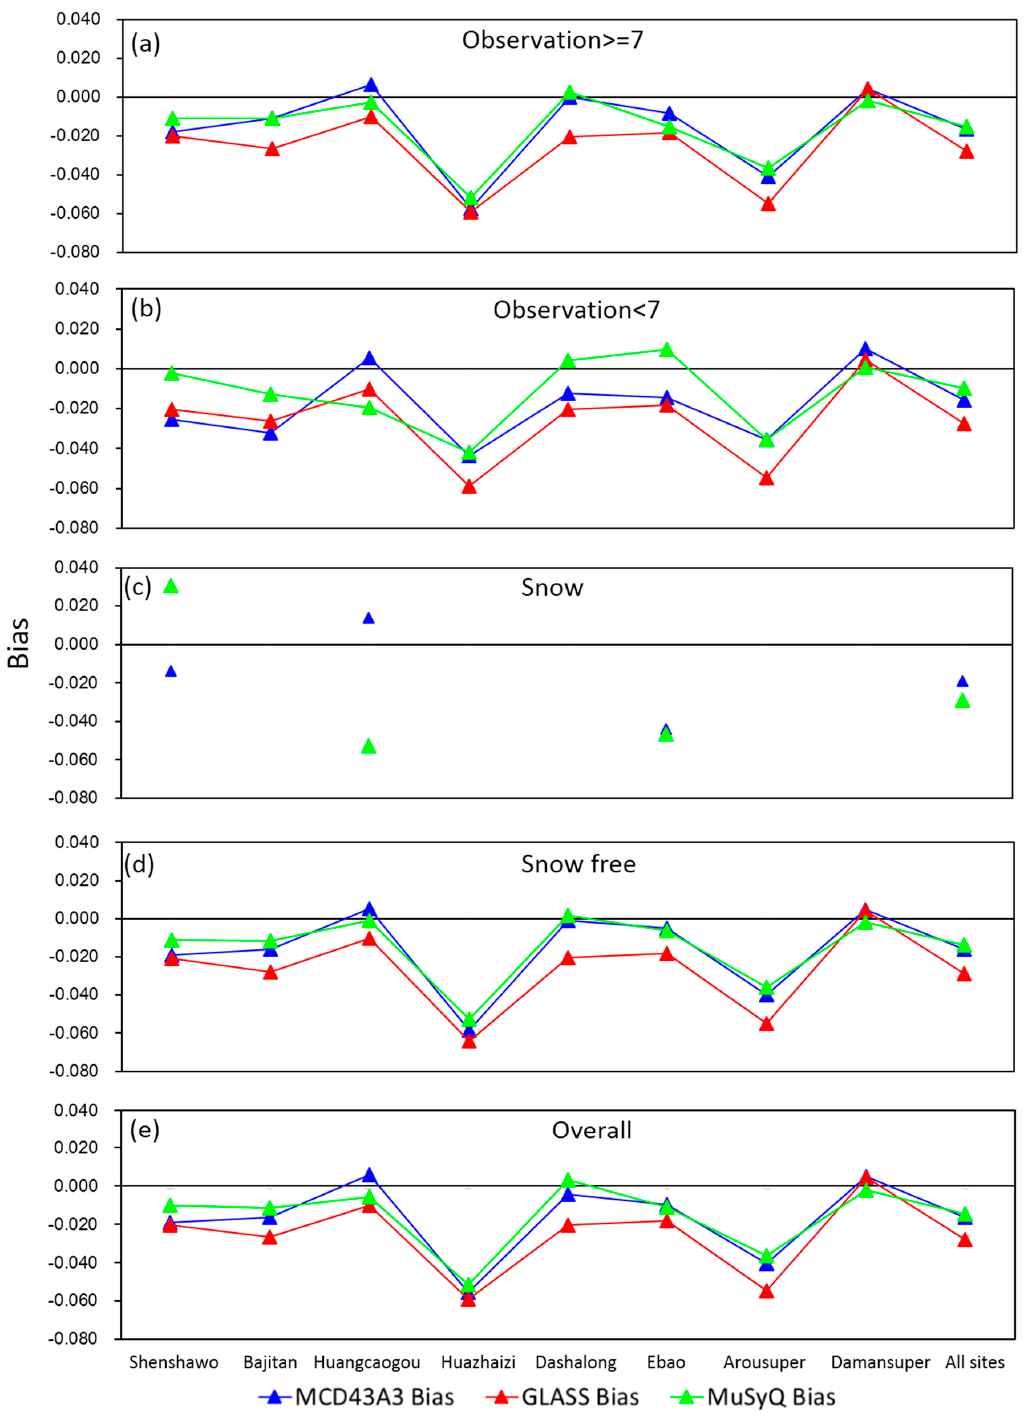
Figure 5. The comparisons of the Biases between MCD43A3 (V006), GLASS and MuSyQ albedos from the direct comparison with ground-observed albedo: ( a ) Observation ≥ 7, ( b ) Observation < 7, ( c ) Snow, ( d ) Snow free, ( e ) Overall.